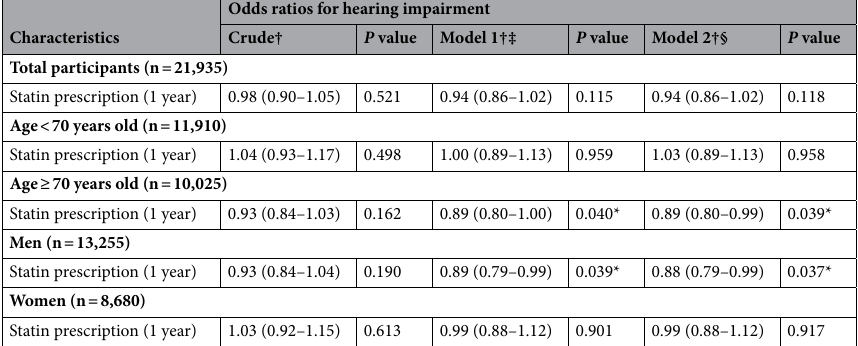
Table 2. Crude and adjusted odd ratios (95% confidence interval) of date of statin prescription (1 year) for hearing impairment with stratified subgroup according age and sex. Abbreviations: CCI, Charlson Comorbidity Index; *Conditional logistic regression analysis, Significance at P < 0.05. † Stratified model for age, sex, income, and region of residence. ‡ Model 1 was adjusted for SBP, DBP, fasting blood glucose, total cholesterol, hemoglobin, and dyslipidemia. § Model 2 was adjusted for model 1 plus obesity, smoking, alcohol consumption, and CCI scores.